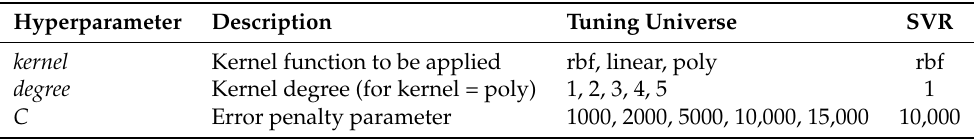
Table 5. Optimal hyperparameters (last column) and their search spaces for the SVR